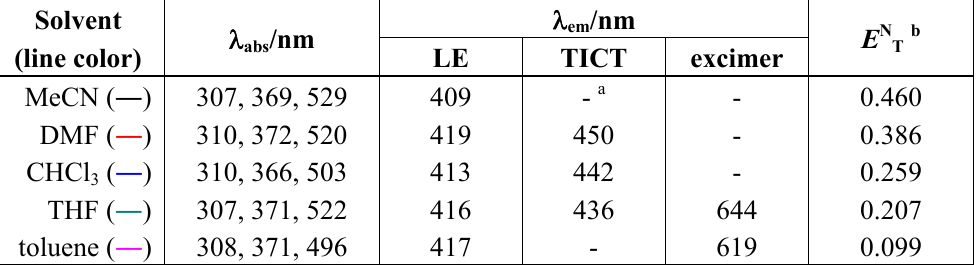
Table 1. Photophysical parameters of the fluorenone